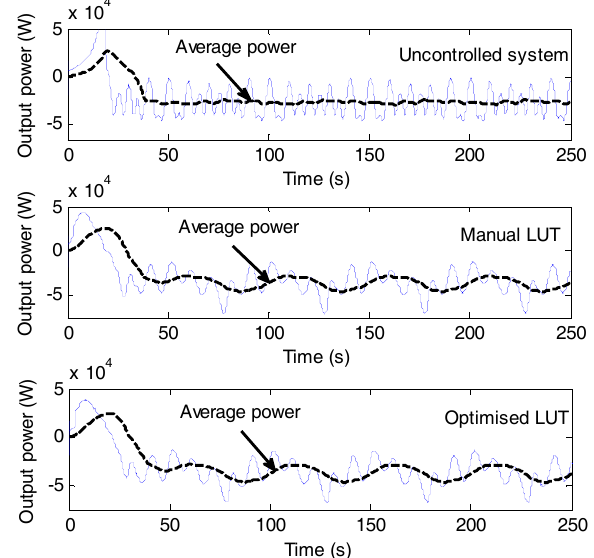
Figure 13. Electrical output power for MPPT algorithm under irregular waves.